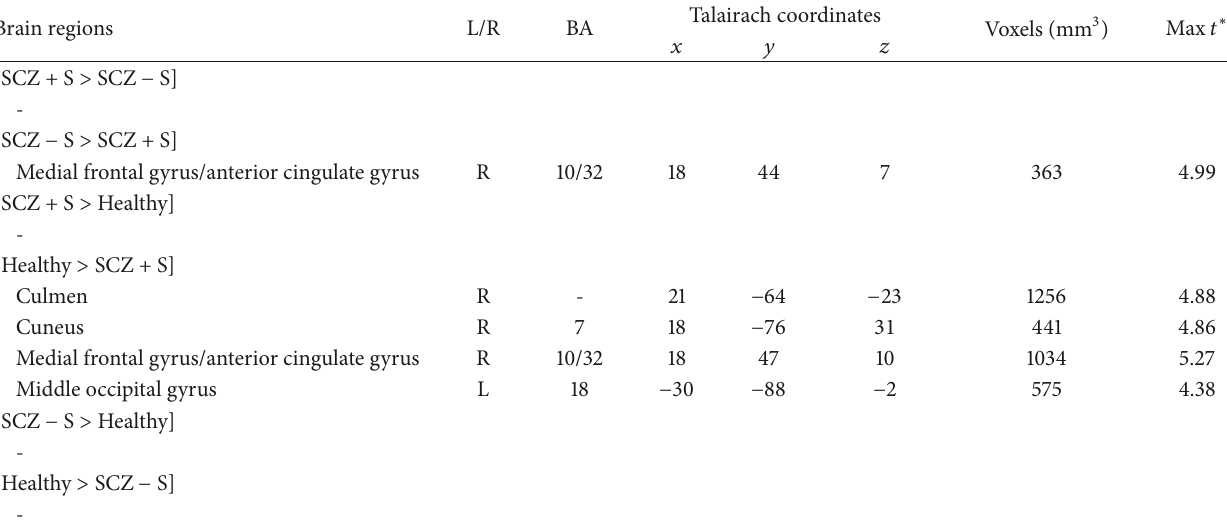
Table 4: Differences in activations between schizophrenia patients (with and without suicidal behavior) and healthy subjects during the parametrically modulated Success